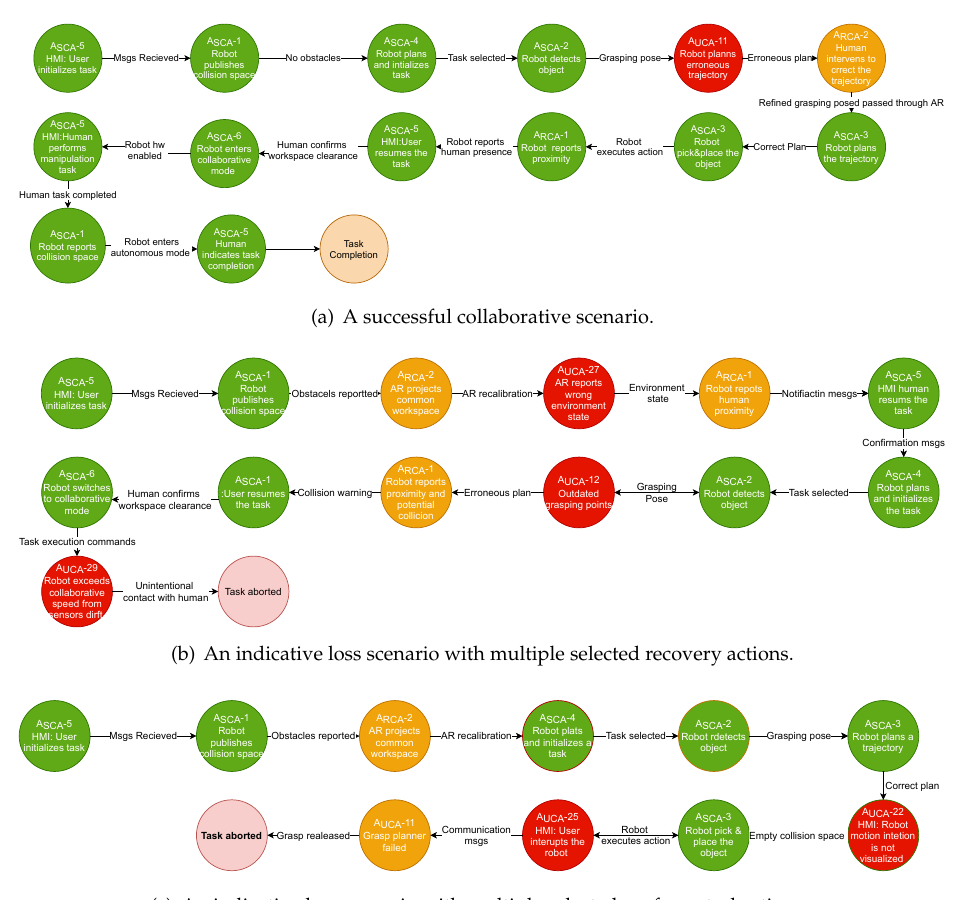
Figure 5. Example of state diagrams corresponding to three different different simulation executions. In ( a ), the collaborative task has been completed normally with only one unsafe control action, in ( b